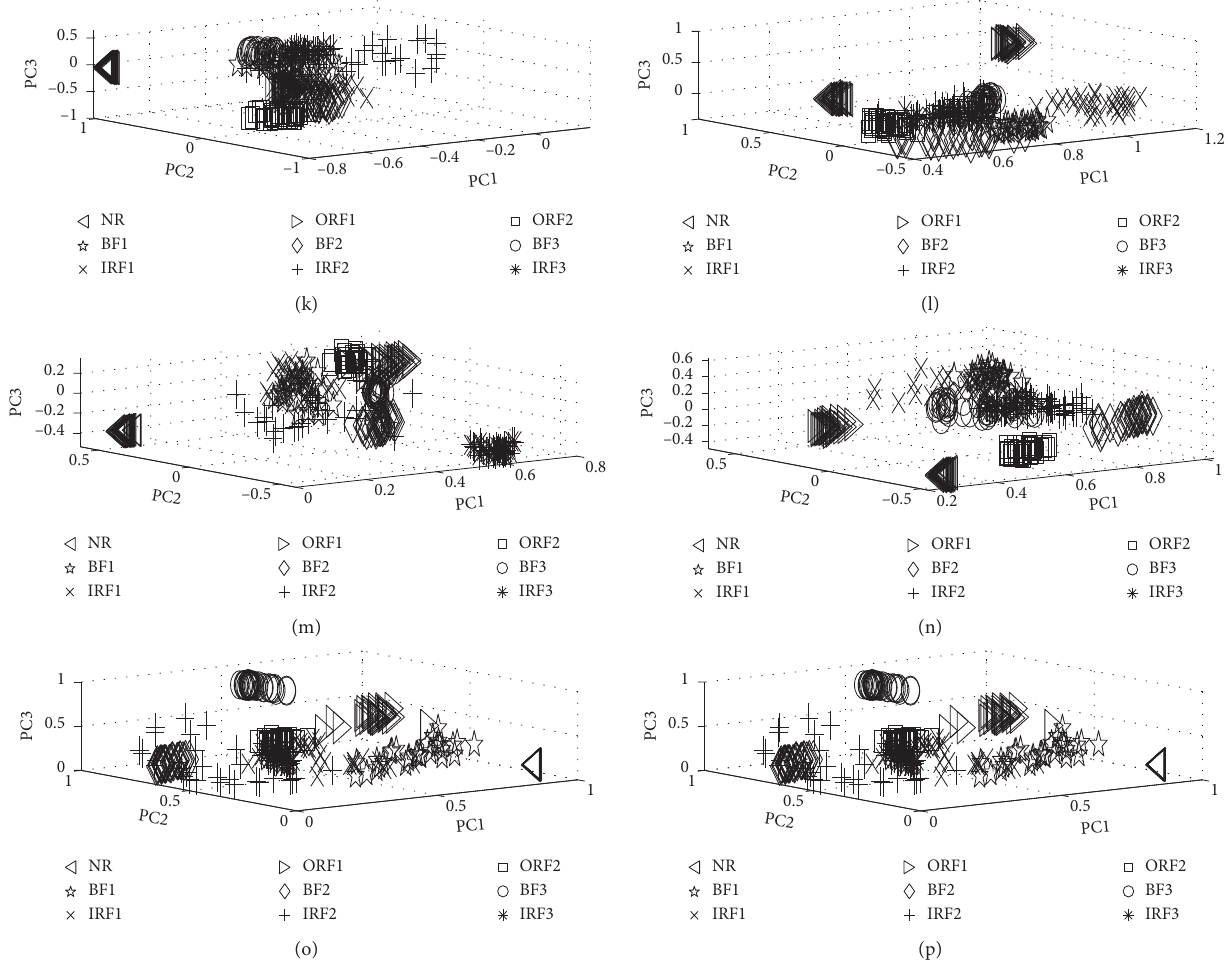
Figure 7: The 3-dimensional results of different datasets for the training dataset through eight hidden layers by using an SAE with PCA dimension reduction; 1–8 denote the hidden layer number. (a) SAE-A-512-training data. (b) SAE-B-512-training data. (c) SAE-A-256- training data. (d) SAE-B-256-training data. (e) SAE-A-128-training data. (f) SAE-B-128-training data. (g) SAE-A-64-training data. (h) SAE- B-64-training data. (i) SAE-A-32-training data. (j) SAE-B-32-training data. (k) SAE-A-16-training data. (l) SAE-B-16-training data. (m) SAE-A-8-training data. (n) SAE-B-8-training data. (o) SAE-A-3-training data. (p) SAE-B-3-training